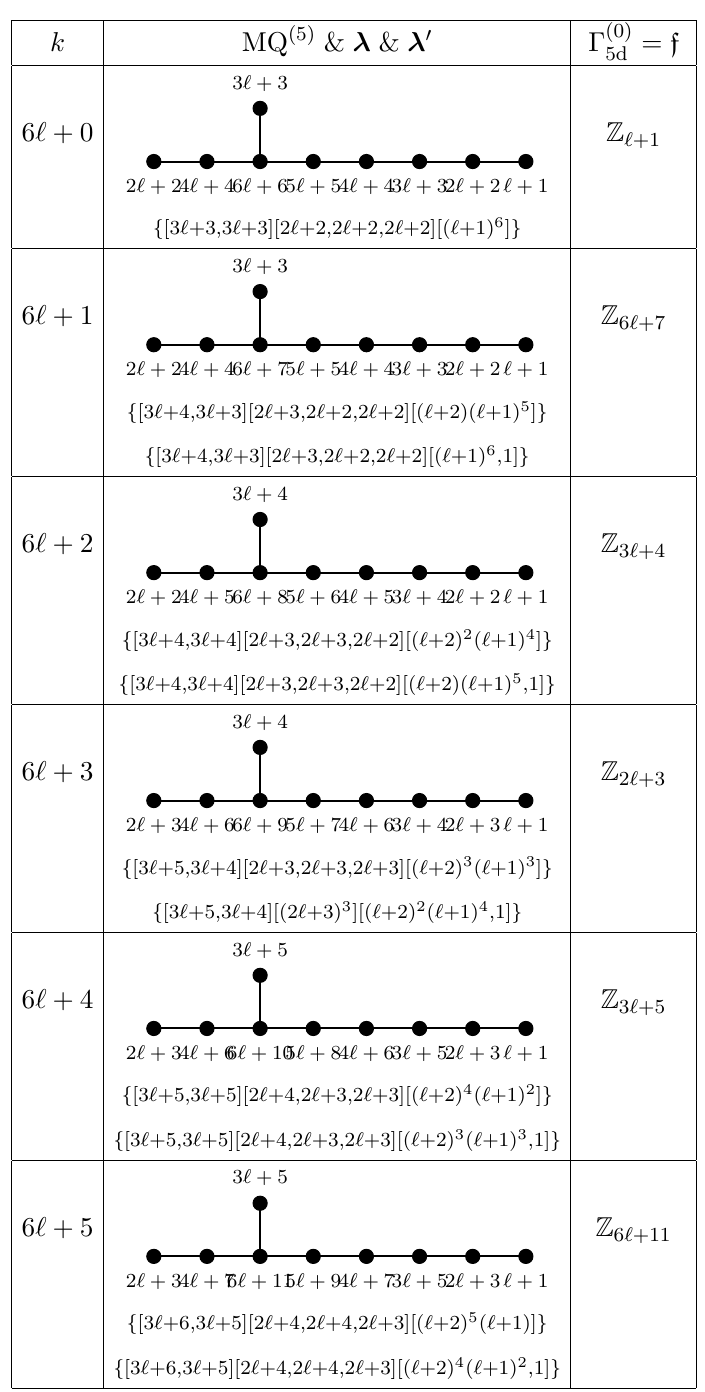
models. We list the partitions λ that underlies these Table 9 . Magnetic quivers for the E ( k ) 8 models, the one after the box-lifting λ 0 , as well as the 0-form symmetry of the associated 5d